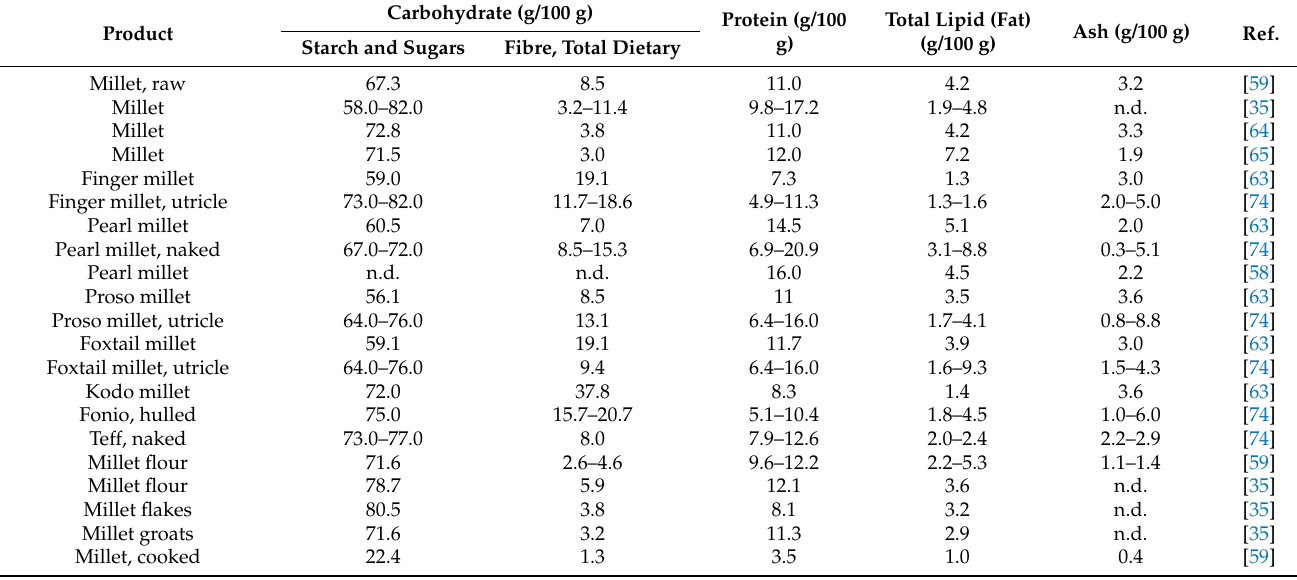
Table 3. Basic ingredients of millet product per 100